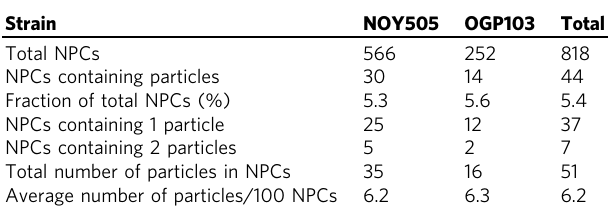
Table 1 Quanti fi cation of NPCs containing large, electron- dense particles Strain NOY505 OGP103 Total Total NPCs